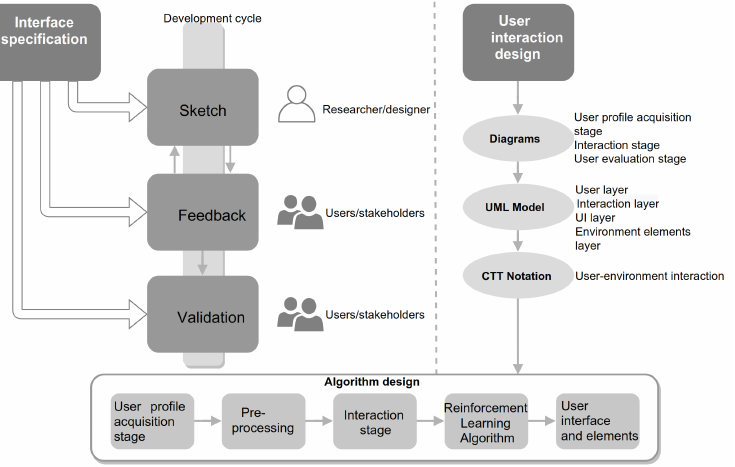
Figure 7. Design phase of proposed